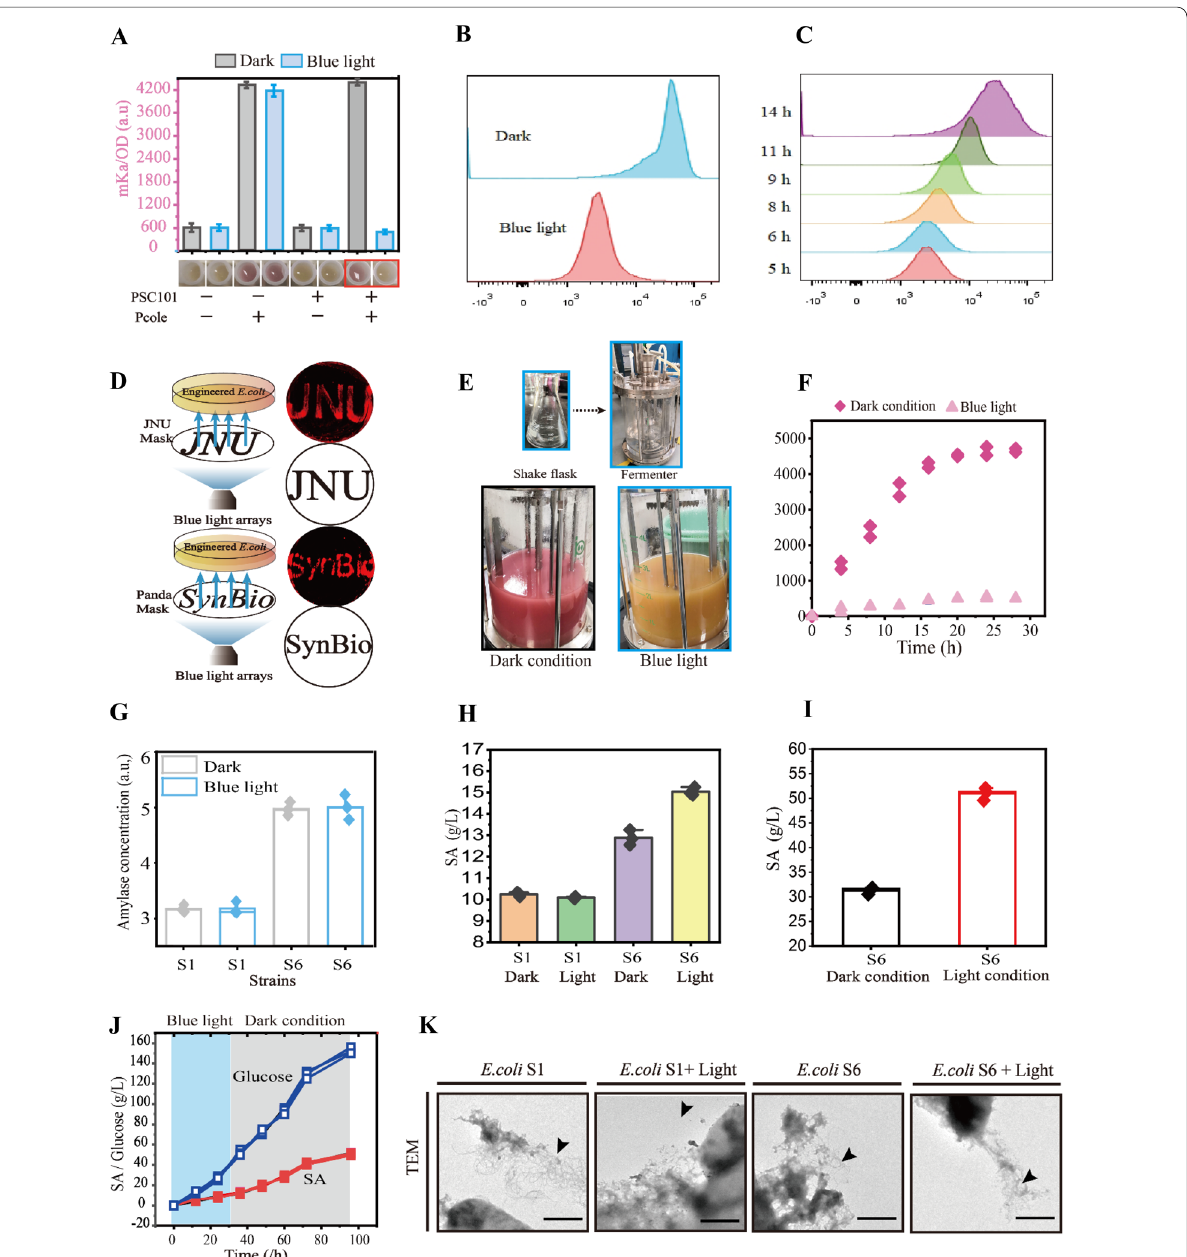
Fig. 4 Increasing shikimate production by biofilm self-assembly. A Fluorescence repression with BLRS under different conditions. B , C Fluorescence repression detection through Flow cytometer analysis under the different conditions. D Bioimage for “JNU” and “SynBio” was achieved through utilizing BLRS system. E The BLRS system scaled up to 5 L fermenter under the blue light and dark conditions. F The Fluorescence repression of BLRS system in the 5 L fermenter under the blue light and dark conditions. G Comparing the enzyme concentration with different strains. H Comparing the shikimate titer with different strains. I S hikimate production with 3.6 L fermenter by light stimulation during fed-batch fermentation with E. coli S6. J S hikimate production in the 3.6 L fermenter with two stage fermentation. K The formation of biofilm-based SpyTag/SpyCatcher system of E. coli S1 and S6 under the light or dark conditions. For A, G, H, I, n 3. For F, n 2. Error bars, mean s.d. Scale bar for ( K ) is 1 = = ±